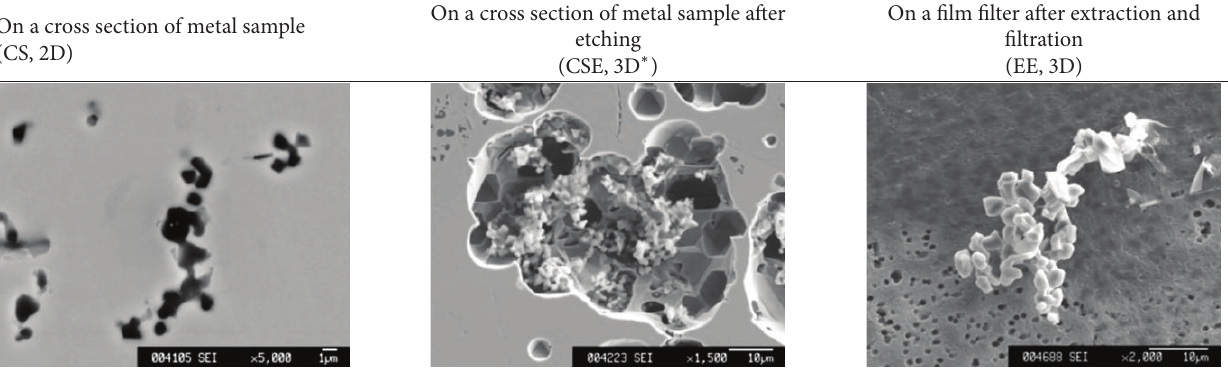
Table 2: Typical SEM images of clusters obtained by different methods applied in this study for 2D and 3D investigations of nonmetallic inclusion particles and clusters in metal samples. On a cross section of metal sample